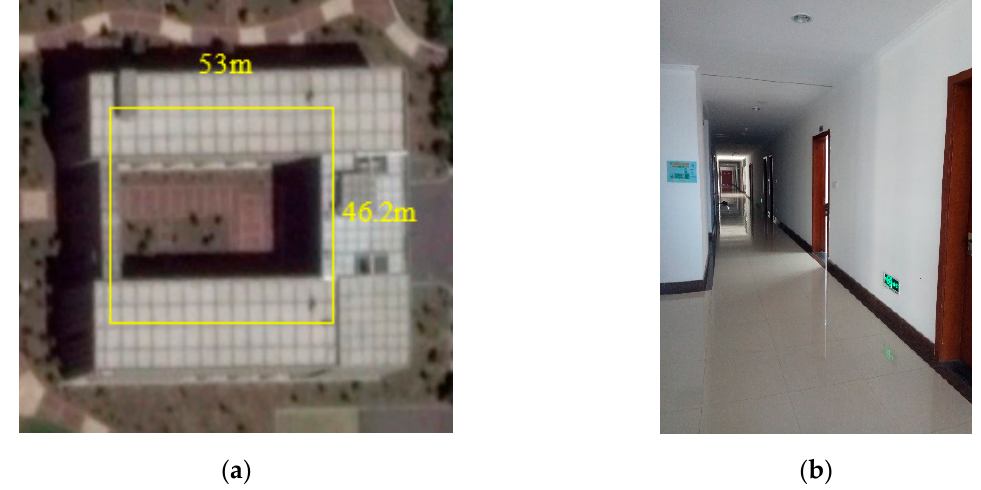
Figure 8. The environment of the walking experiments: ( a ) display of experiment area on Baidu map; ( b ) a corridor of the experiment area.